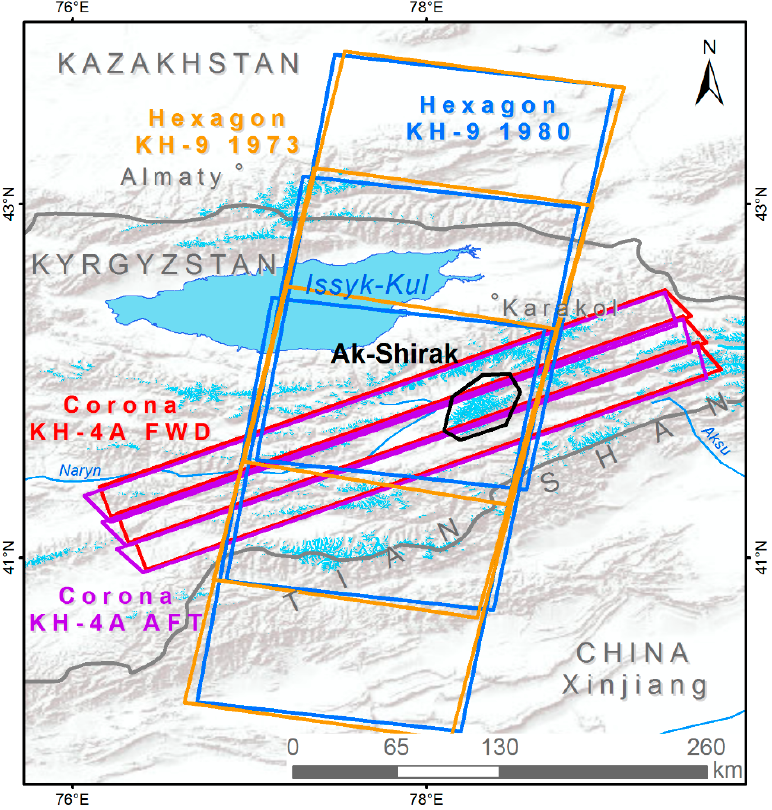
Figure 3. Corona and Hexagon scene coverage of the study area.